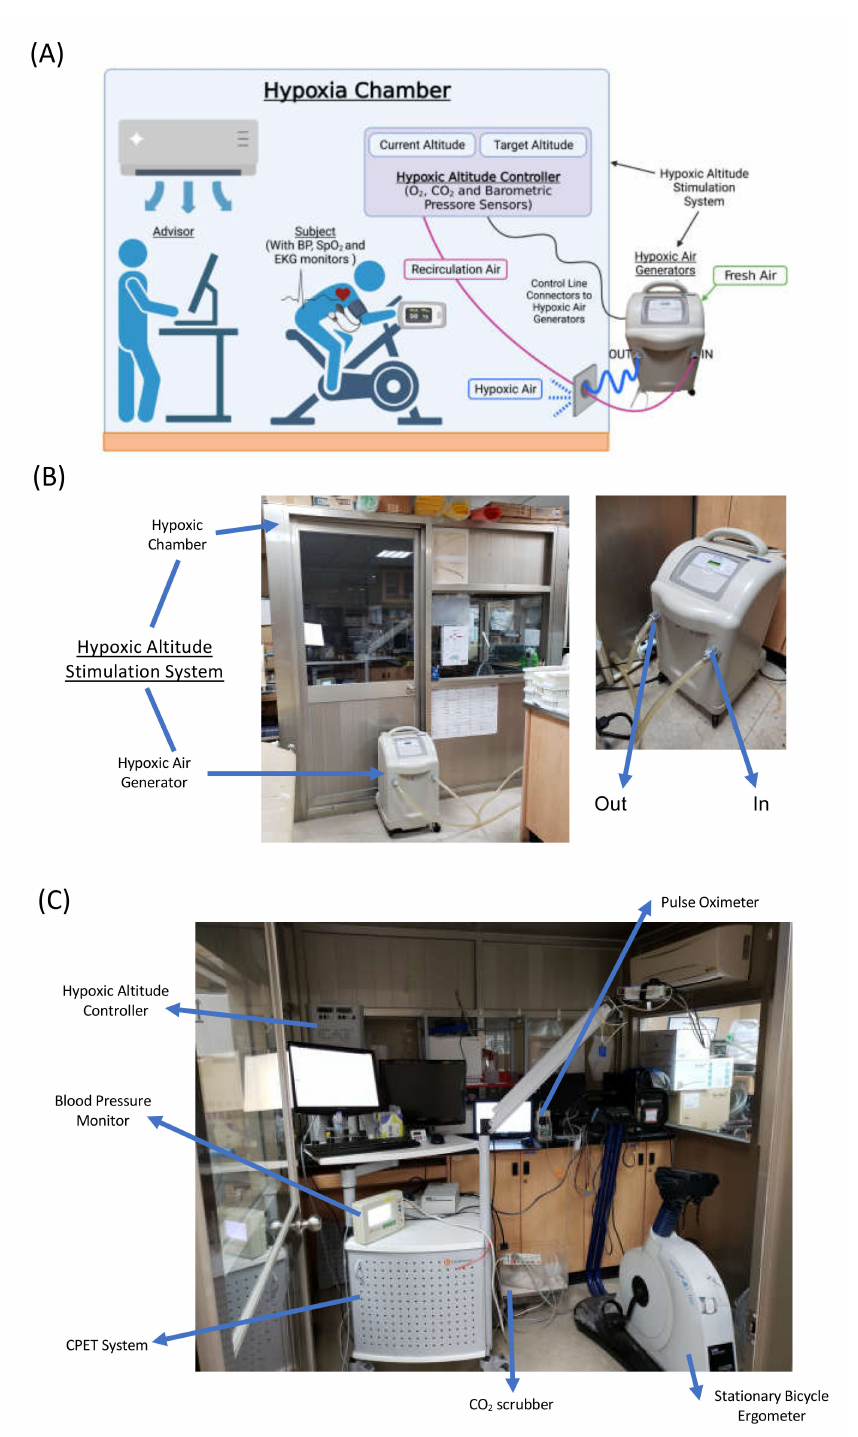
Figure 1. Experimental setup: ( A ) schematic representation of hypoxia chamber setup; running hypoxia experiment: ( B ) the outside of the chamber; ( C ) the inside layout of the